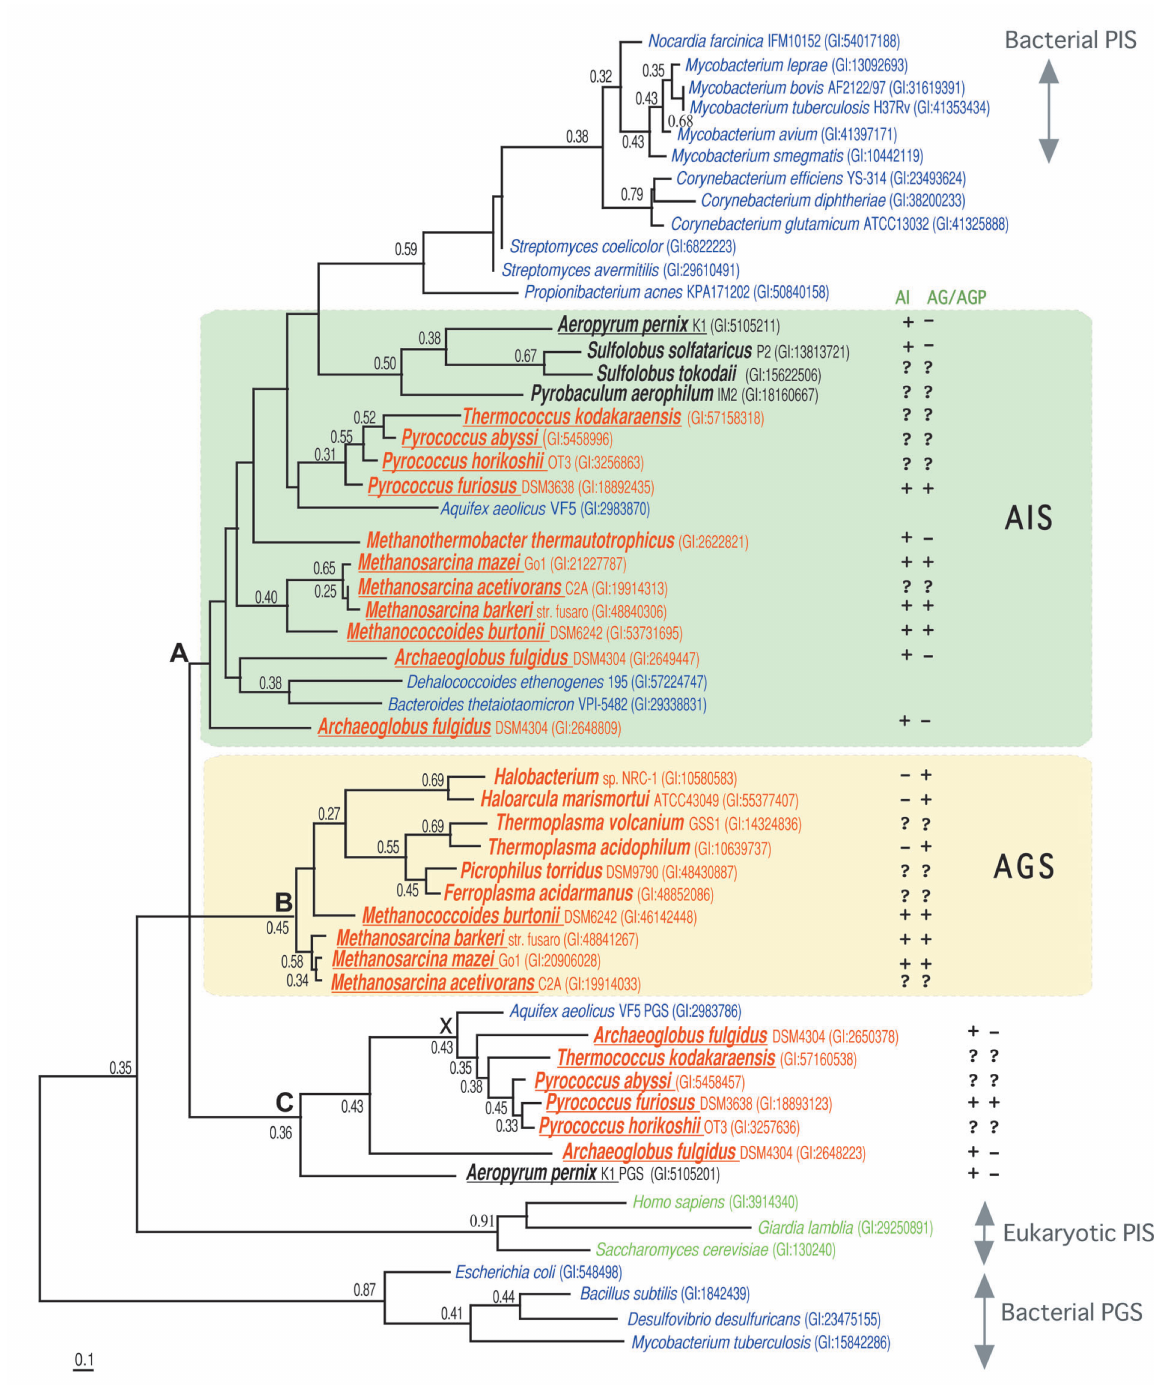
Figure 6. An unrooted maximum likelihood tree of phosphatidylglycerol synthase/archaetidylglycerol synthase (PGS/AGS) and phosphatidyl- inositol synthase/archaetidylinositol synthase (PIS/AIS). Each sequence is indicated by the source name and the GI number from the National Center for Biotechnology Information. The proteins from Euryarchaeota, Crenarchaeota, Bacteria and Eukarya are colored red, black, blue and green, respectively. The underlinedspecieshave paraloguesin the tree. The reliabilityindex of a clusteris only shown when the value is equal to or greater than 0.25. The log likelihood was –9599.24 and the optimal shape parameter alpha was 1.03 (119 sites). The presence or absence of archaetidylinositolor archaetidylglycerol/archaetidylglycerolphosphoatein each speciesisindicatedby a symbol,‘+’or ‘–’, afterthe source name and GI number.The symbol, ‘?’, indicates that the lipid composition has not been reported for the species. The characters, ‘A’, ‘B’, ‘C’, and ‘X’, areexplainedinthetext. The groupsconsistingofAIS and AGS candidatesareenclosedwithinlightgreenand lightyellow